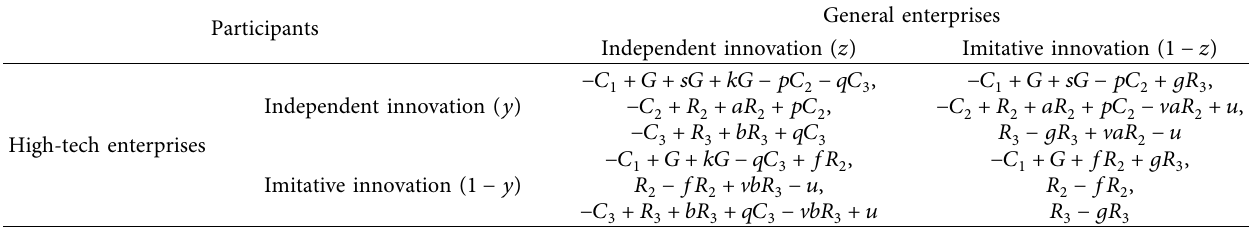
Table 1: Tripartite game payoff matrix when the management committee chooses “incentive regulation.”